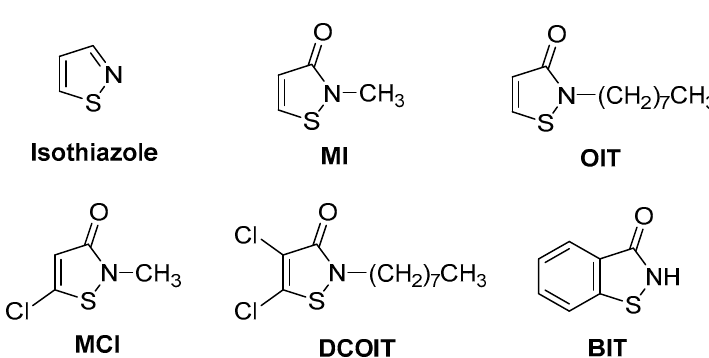
Figure 1. Chemical structures of isothiazole and of the most frequently used isothiazolinone biocides in consumer products.